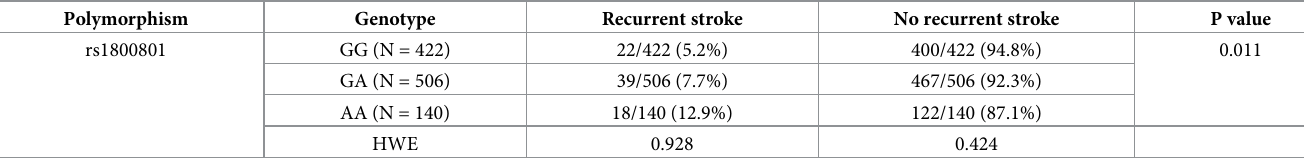
Table 2. Genotype frequencies of SNP rs1800801.